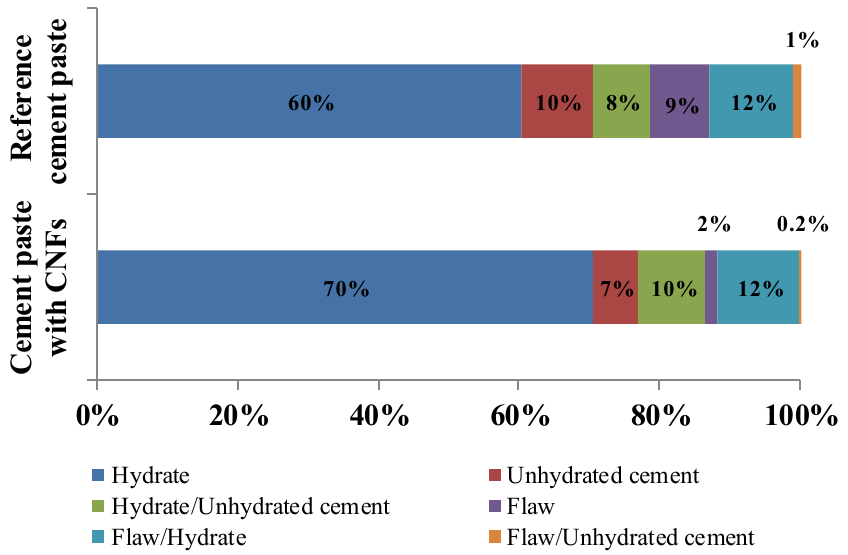
Figure 6. Visual microstructural classification of indents based on SEM image analysis for the refer- ence cement paste and the cement paste with CNFs.